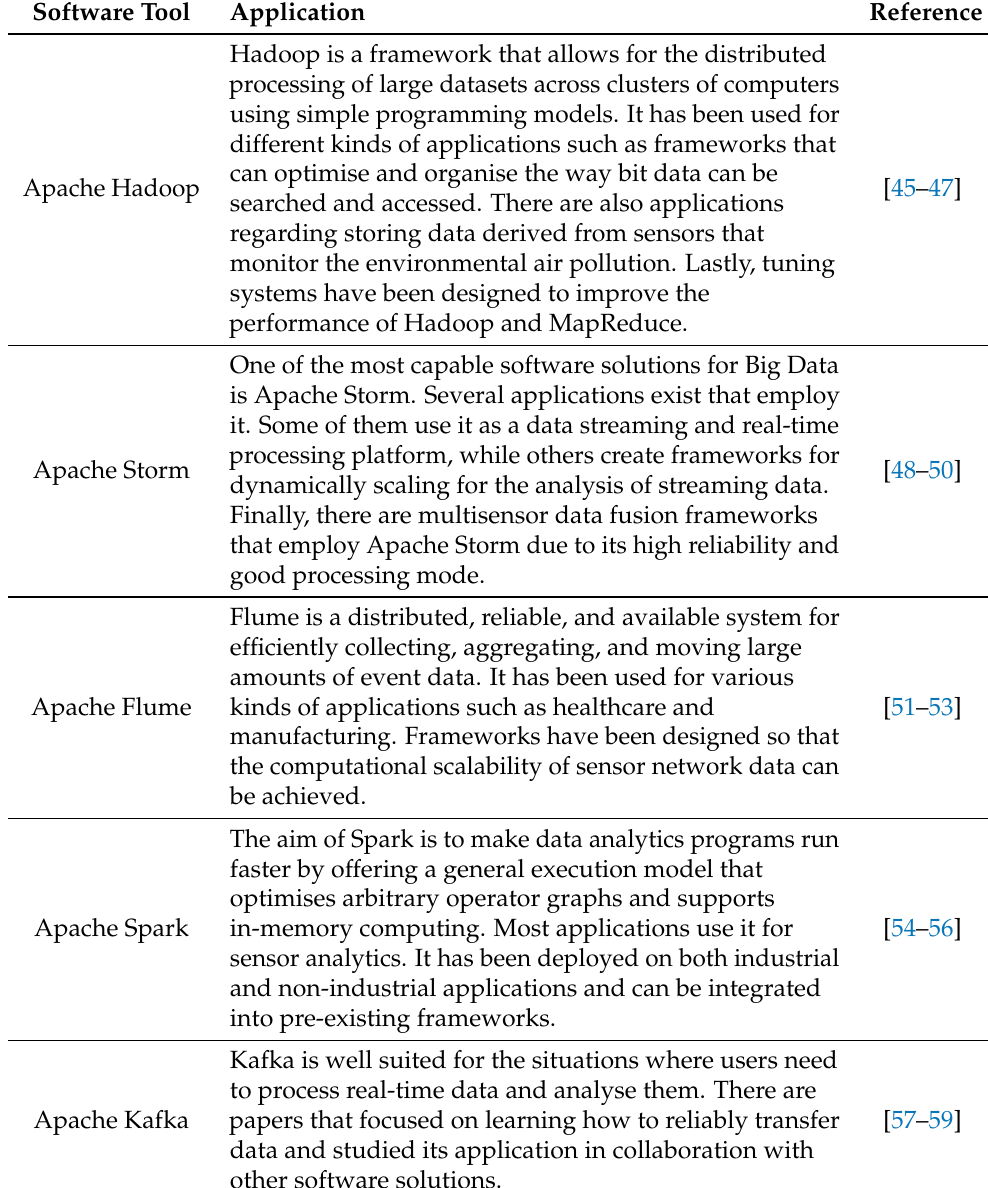
Table 1. Applications of software tools for data